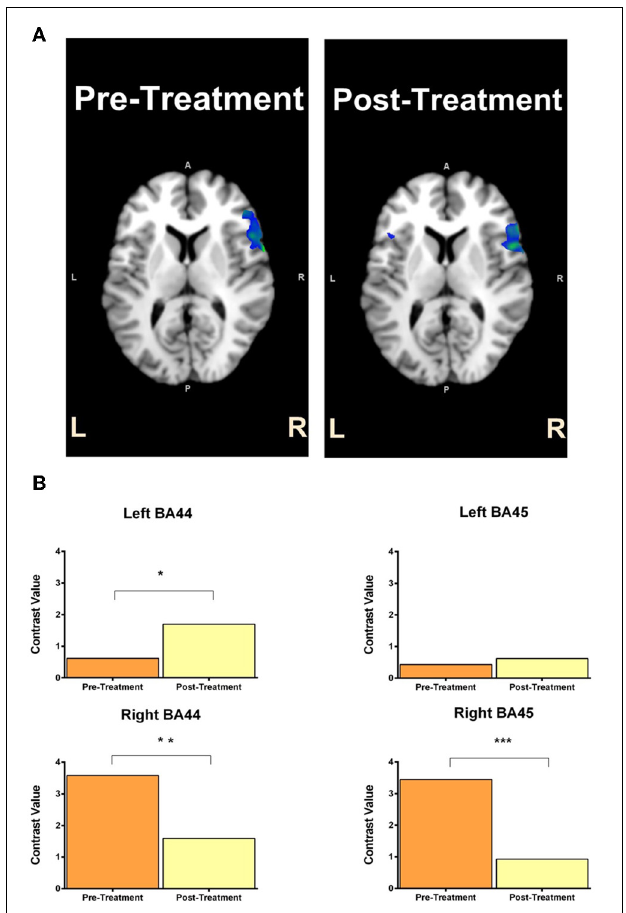
FIGURE 6 | AMC’s statistical activation within the ROI (left Broca’s area and right Broca’s homolog) is shown in panel (A) for the contrast of speaking vs. fixation in the automatic speech task. The reconstructed ROIs for pre-treatment and post-treatment are projected on the axial anatomic background (MNI) reference brain. Panel (B) reflects contrast value scores related to ROI activity in the pre-treatment and post-treatment scans for AMC (with 95% CI) in the automatic speech task. Contrast value refers to the value of ß in the analyzed contrasts of pre-treatment > post-treatment (top) and post-treatment > pre-treatment (bottom). Asterisk ∗ indicates p < 0 . 05 uncorrected, ∗∗ reflects p < 0 . 01 uncorrected and ∗∗∗ denotes p < 0 . 001